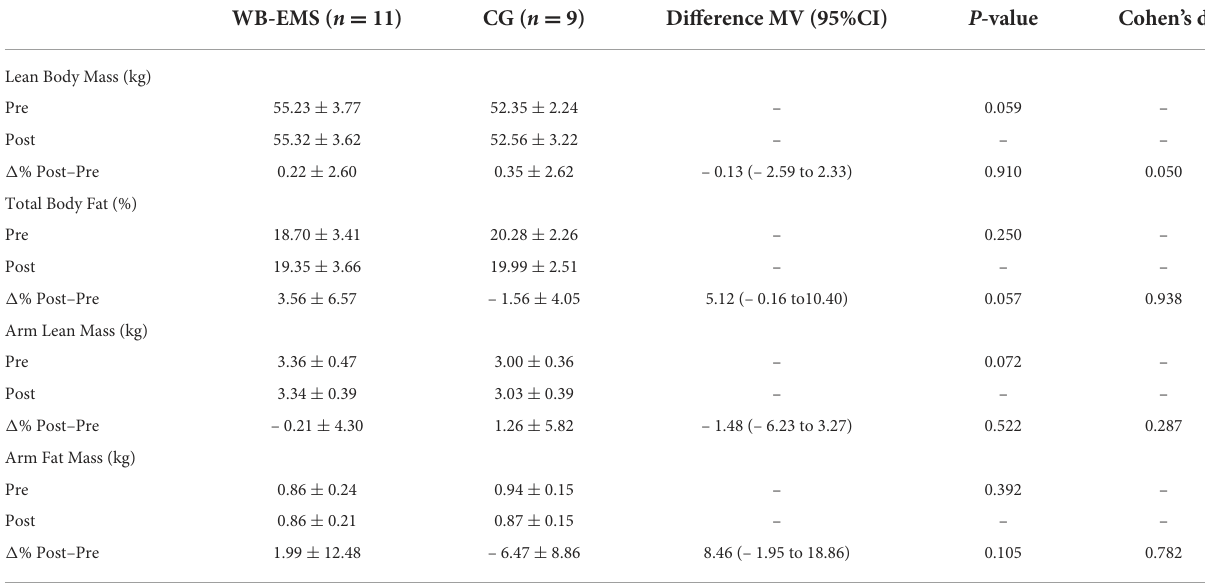
TABLE 4 Baseline, follow-up data and percentage increases ( 1 %) of secondary outcomes for WB-EMS group and the